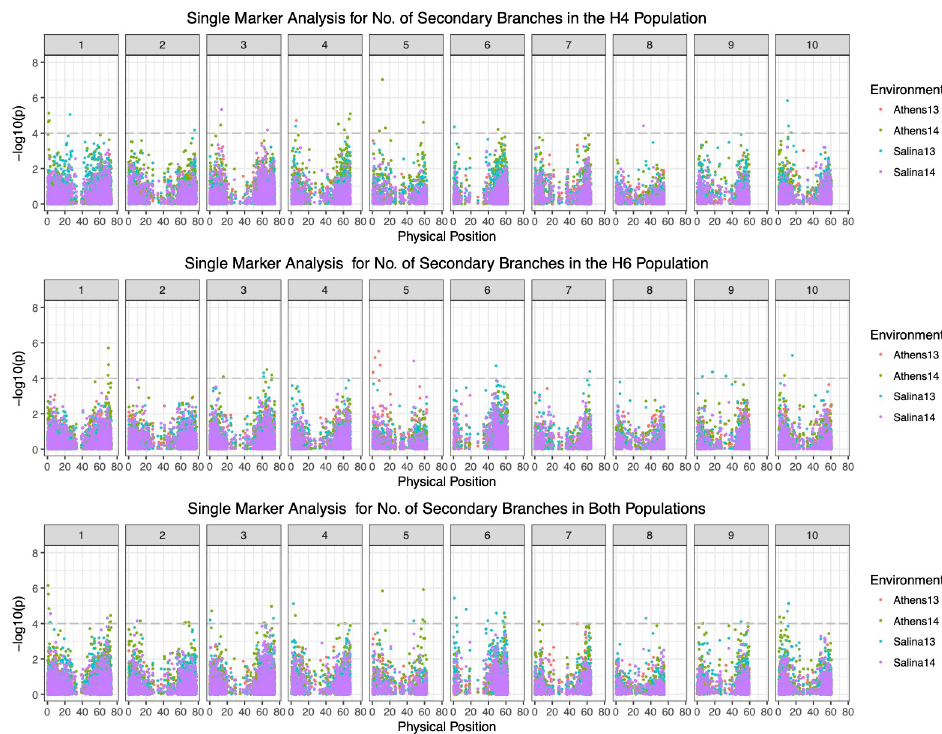
Fig 4. Single marker analysis for the number of secondary branches per tiller in the H4, H6-derived and the pooled BC 1 F 2